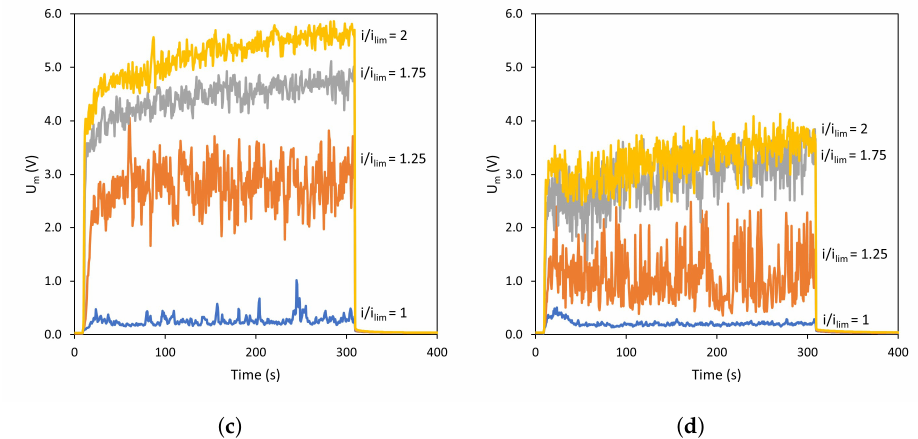
Figure A2. Chronopotentiometric response obtained with AMV-N membrane and NaCl as electrolyte